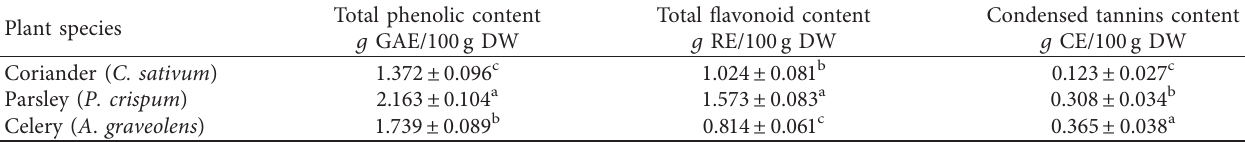
Table 2: Antioxidant activity of studied plant species based on total phenolic, flavonoids, and condensed tannin levels (g GAE/100 g DW).